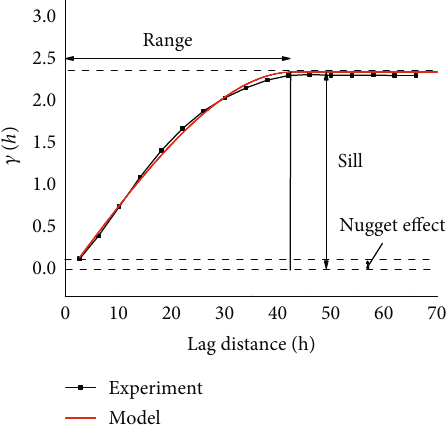
Figure 5: Variograms from the experimental tests and the best- fi t spherical model for the fracture surface.